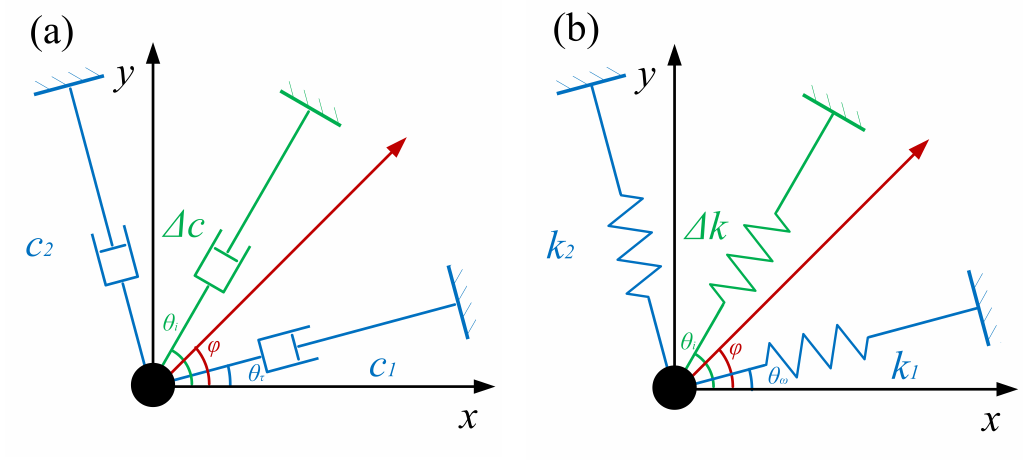
Figure 2. Damping tuning in a two degree-of-freedom resonator. ( a ) Effect on damping and ( b ) effect on